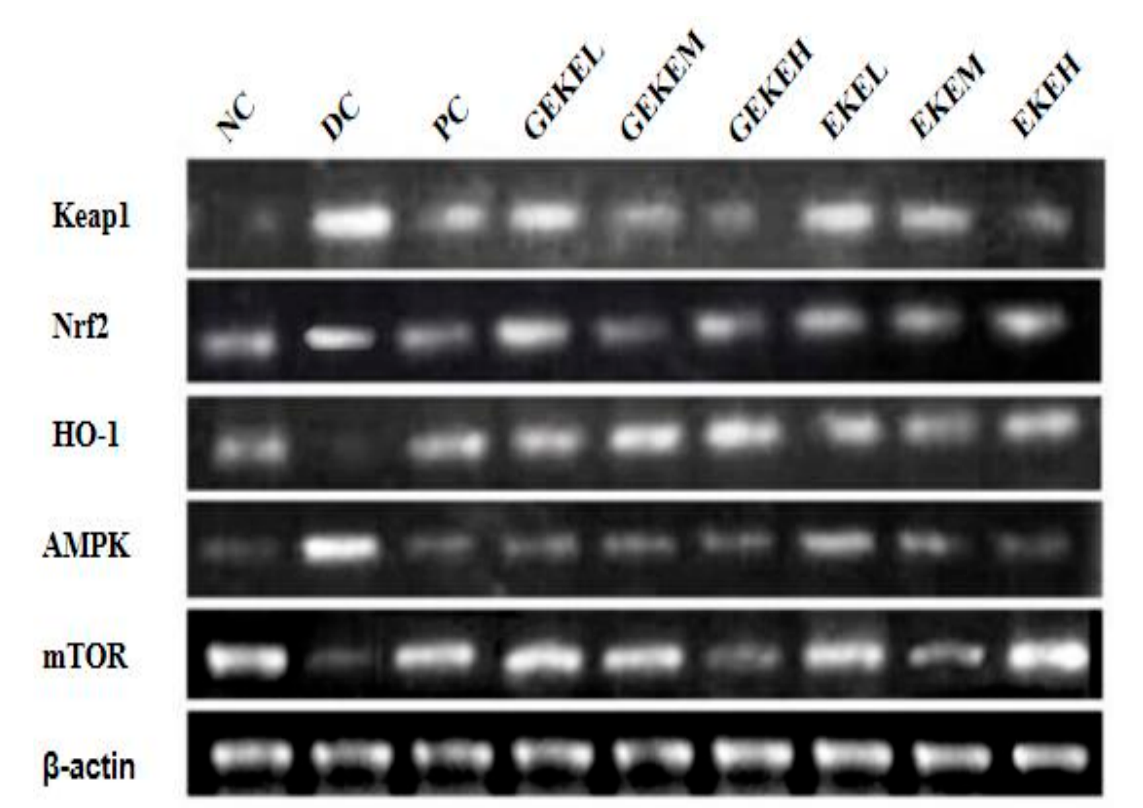
Figure 5. mRNA expression levels of AMPK, mTOR, HO-1, Nrf2, and Keap1 in kidney as detected by RT-PCR.